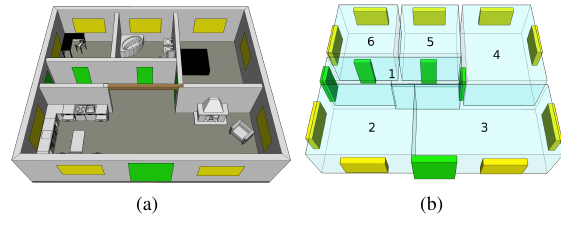
Figure 2. (a) Furnished IFC 3D model. (b) Original indoor space units in the model.